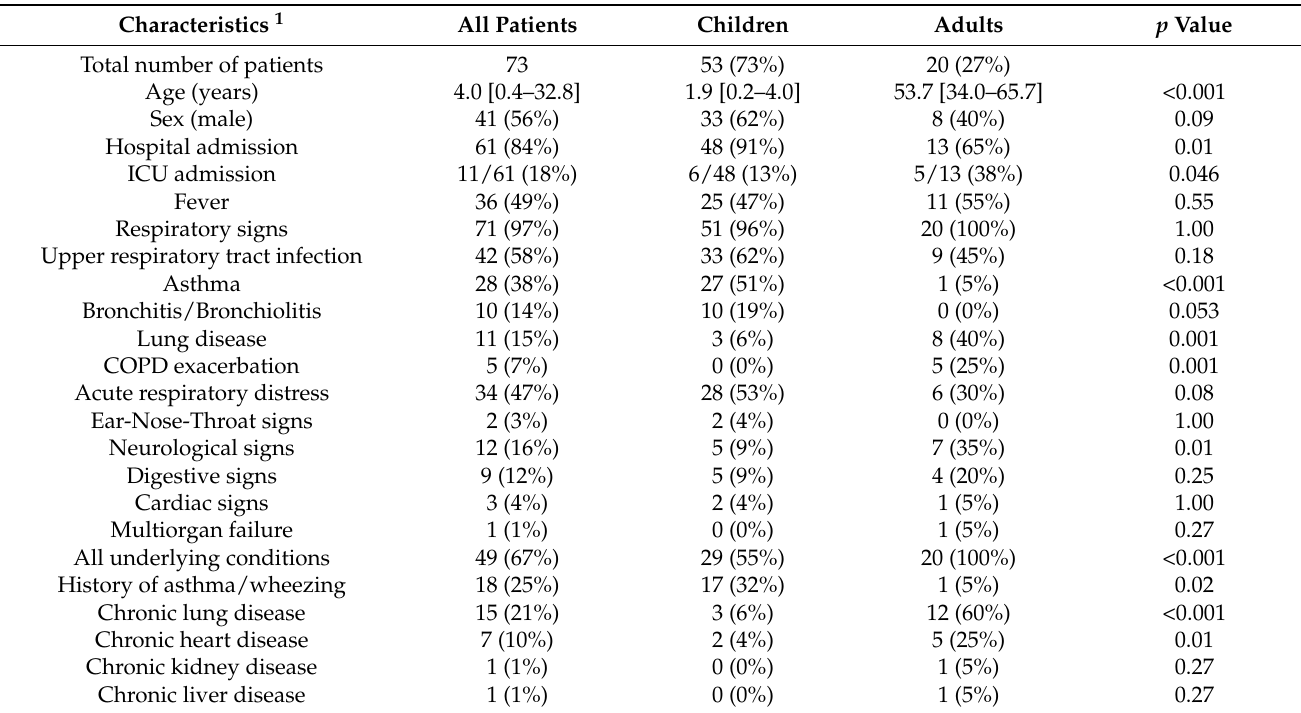
Table 2. Demographic and clinical characteristics of patients presenting to the University Hospital, Clermont-Ferrand with enterovirus D68-associated diseases between 1 June 2014, and 31 December